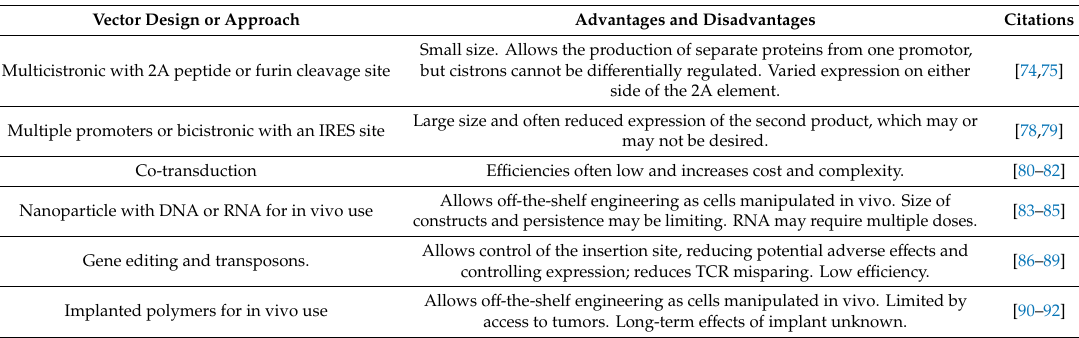
Table 2. Approaches to transduction of cellular therapeutic agents. Vector Design or Approach Advantages and Disadvantages Citations Multicistronic with 2A peptide or furin cleavage